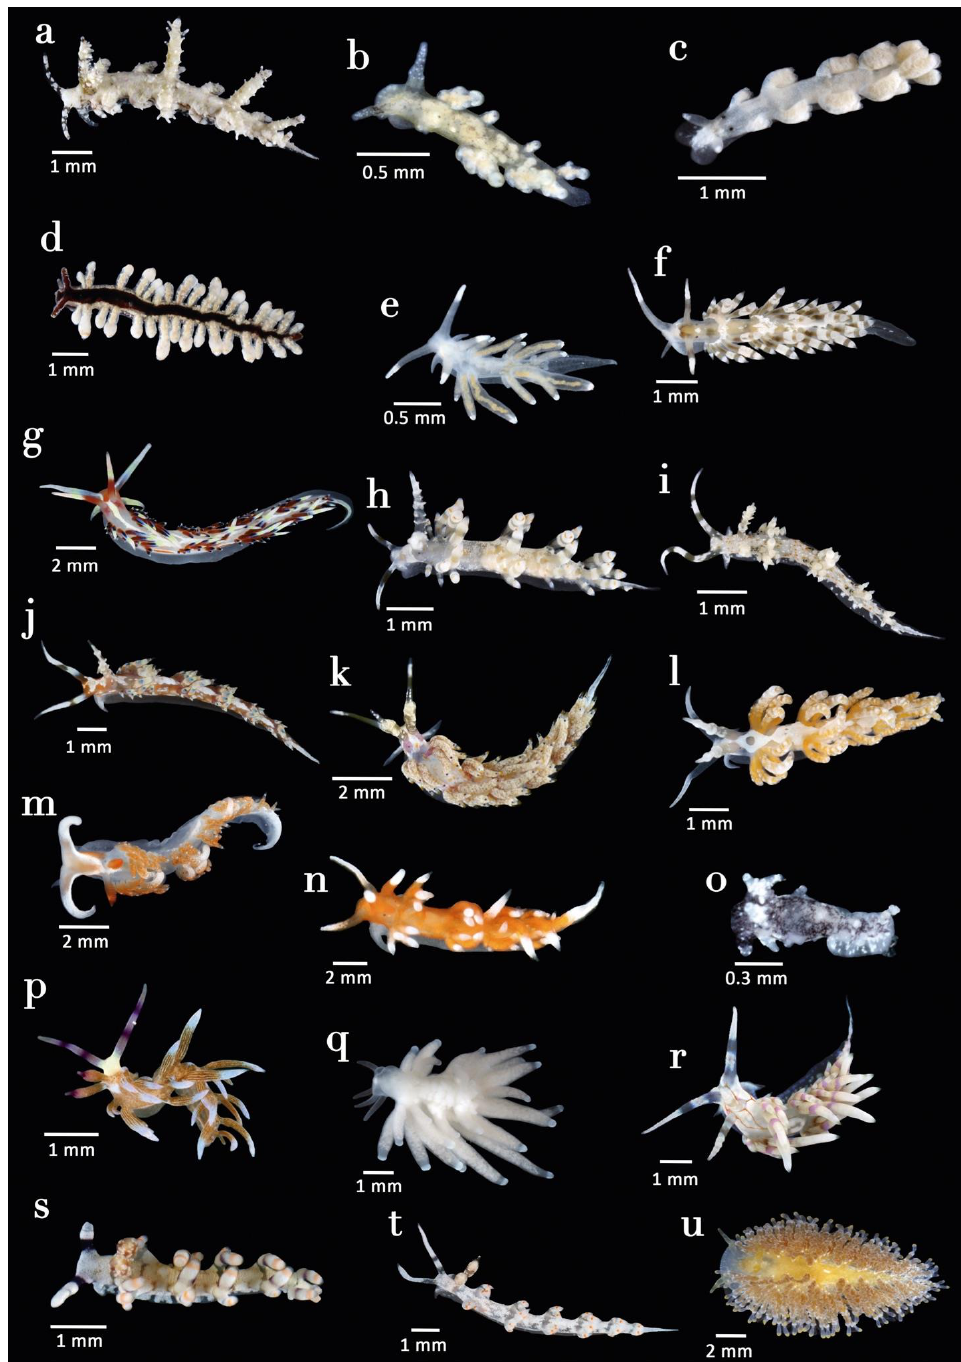
Figure 5. Nudibranchia, Cladobranchia: ( a ) Limenandra evanescenti n. sp. (MCZ:Mala:393766); ( b ) Doto sp. (MCZ:Mala:393816); ( c ) Embletonia gracilis (MCZ:Mala:393844); ( d ) Eubranchus putnami n. sp.